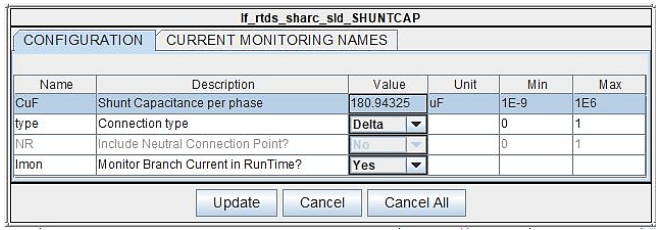
Figure 18. Excitation circuit parameter settings.